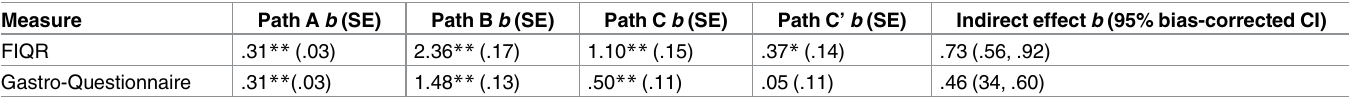
Table 4. Two meditation analysesexamining whether stress (DASS-Stress scores)mediates relationships of personal relative deprivation (PRDS-R scores)and scores on outcome measures.